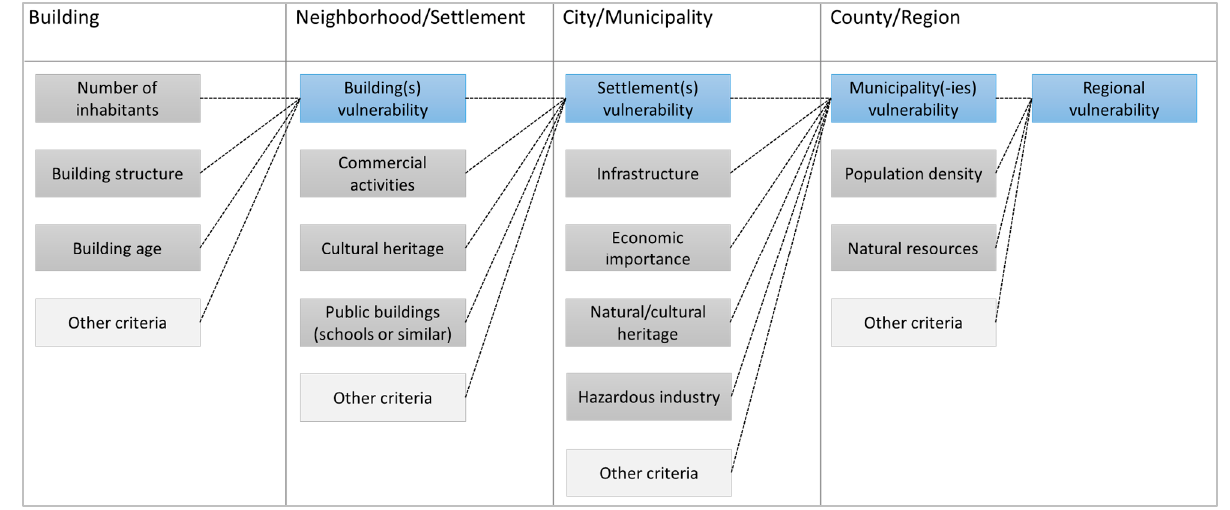
Figure 3. Vulnerability analysis at different scales with multi-criteria